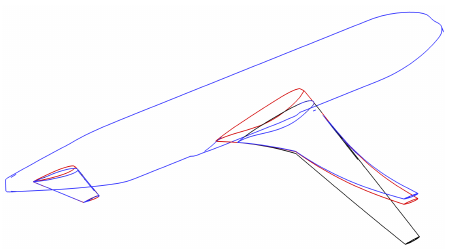
Figure 5. Outlines of the deflected geometries, showing the Euler model’s slightly larger deflection (black: undeflected, blue: deflected Euler, red: deflected